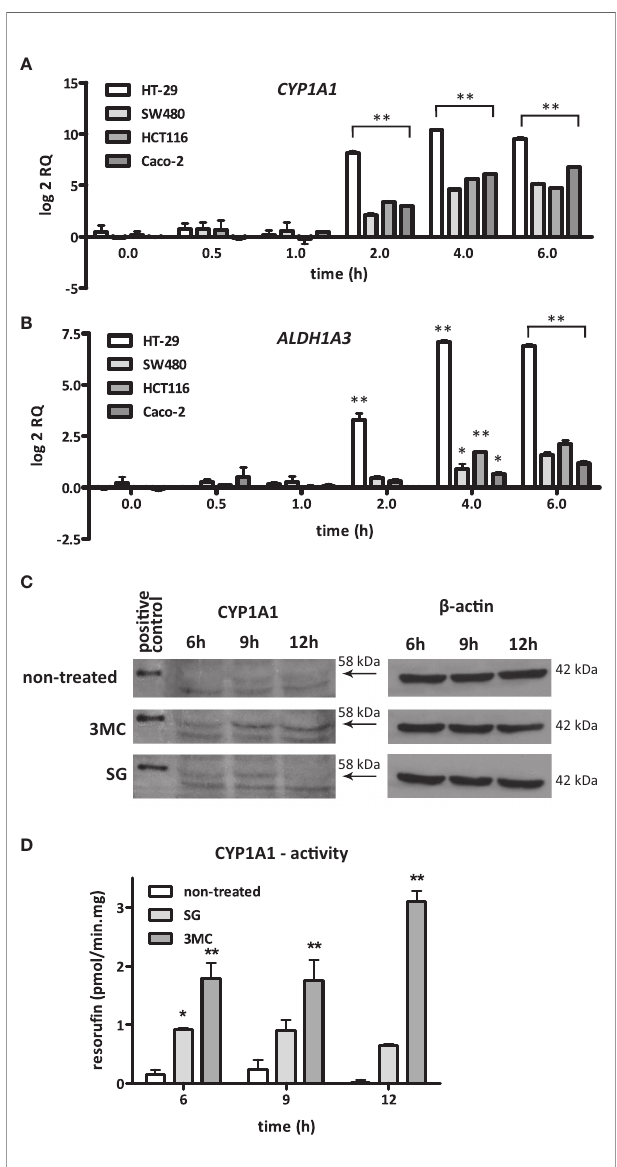
FIGURE 2 | S. gallolyticus-induced CYP1A1 expression. The expression of (A) CYP1A1 and (B) ALDH1A3 was evaluated by qPCR in the CRC cell lines HT-29, SW480, HCT116, and Caco-2 upon 2, 4, and 6 h of incubation with S. gallolyticus UCN34. Note that the expression of CYP1A1 is highly similar in all investigated cell lines. Two-way ANOVA was performed to determine signi fi cant changes (*p < 0.05; **p < 0.01). (C) Protein expression of CYP1A1 in Caco-2 cells was investigated by Western blotting after exposure to S. gallolyticus or 3MC for 6, 9, and 12 h. The arrows indicate the position of CYP1A1 protein (58 kDa). The replicate blots shown in Supplementary Figure S3 illustrate that only the indicated band of 58 kDa is detected by several different CYP1A1 antibodies and con fi rm that only this reactive band speci fi cally appears upon stimulation with 3MC. The right panel shows the corresponding b -actin protein expression levels (42 kDa). (D) CYP1A1 enzyme activity was measured by the 7-EROD assay. The bars indicate the amounts of picomoles resoru fi n produced per minute per milligram protein. Two-way ANOVA was performed to determine signi fi cant changes (*p < 0.05; **p < 0.01). RQ, relative quantity; non-treated cells; 3MC, 3- methylcholanthrene; SG, S. gallolyticus